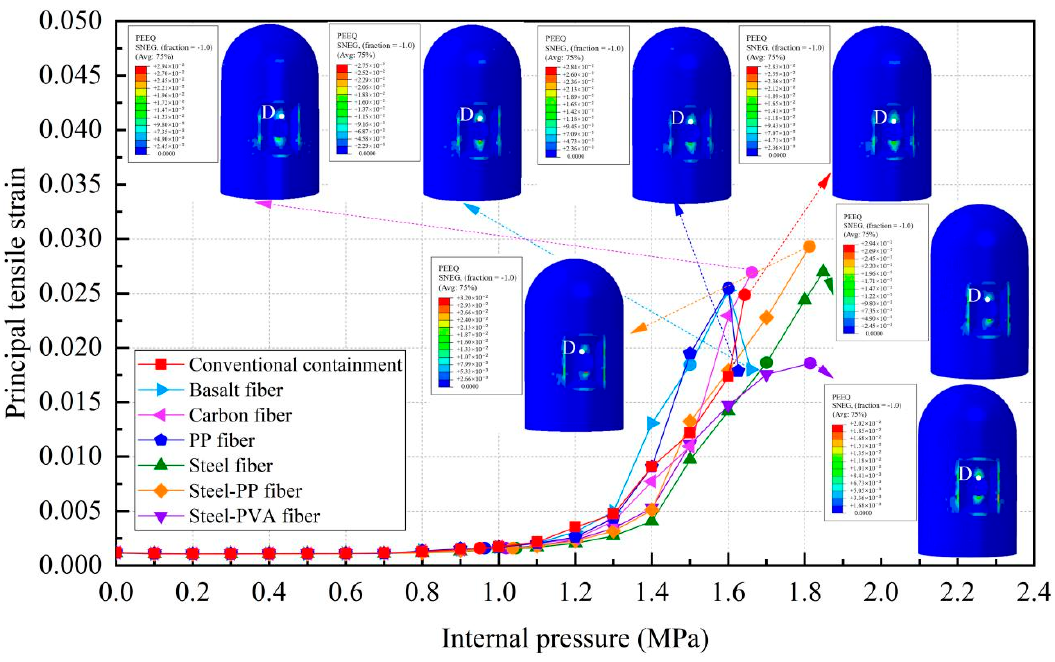
Figure 15. Principal tensile strain of the steel liner (Note: point D is at the apex of the hole).